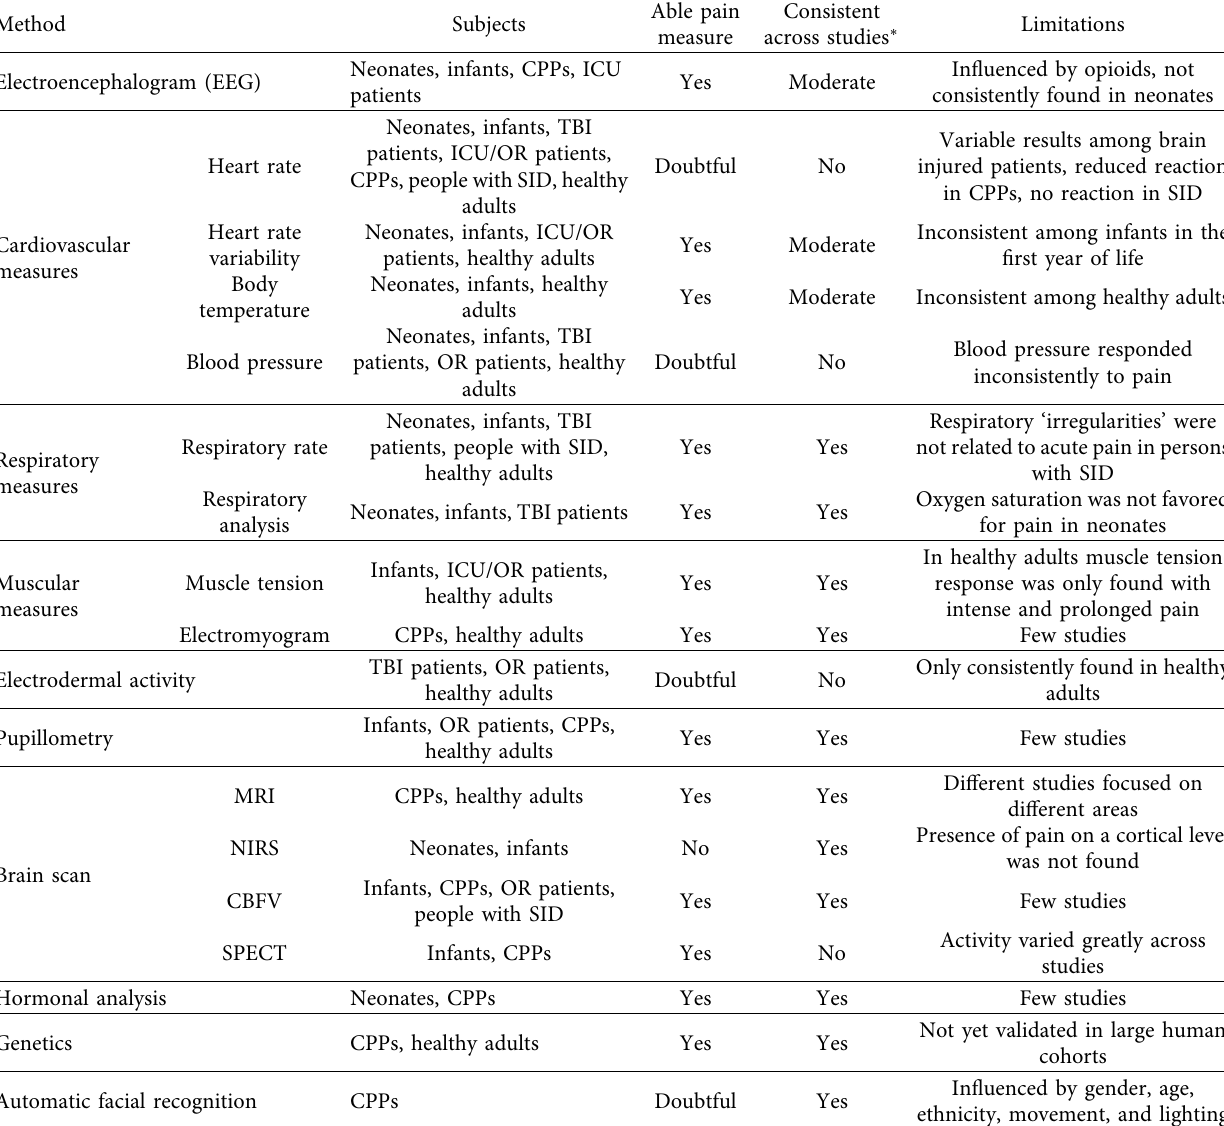
Table 4: Pain assessment results per measurement